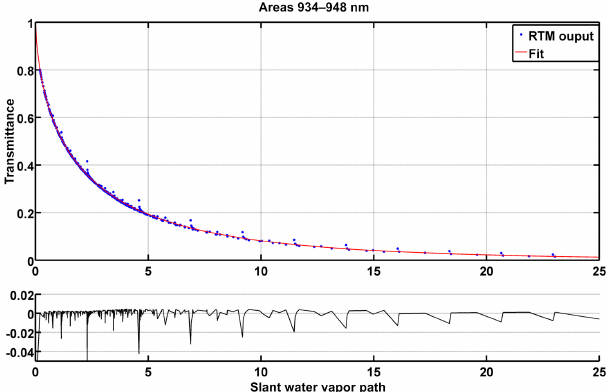
Figure 6. Integrated transmittance of IWV in the 934–948nm win- dow versus the slant water vapour path ( m w ∗ u ) calculated by MOD- TRAN with a third-order polynomial fit (upper plot) and the resid- uals of this fit (lower plot).